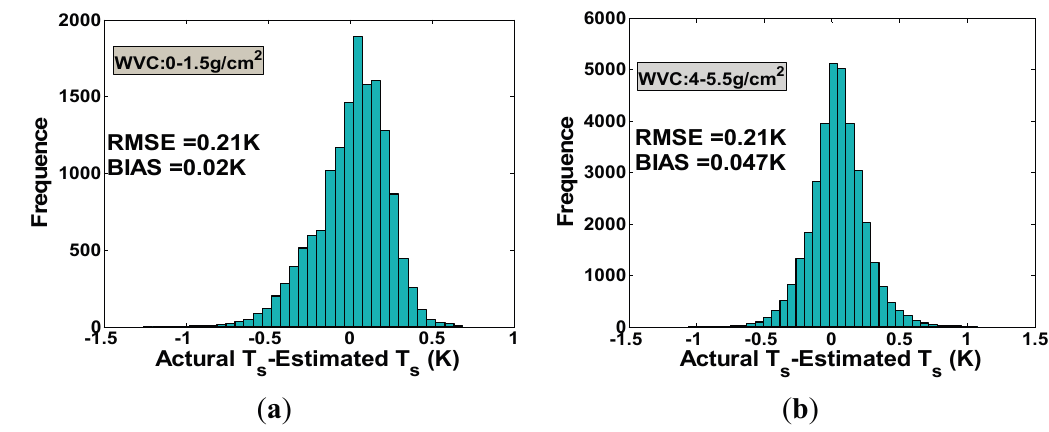
Figure 9. Total LST retrieval error caused by uncertainties of NE Δ T, emissivity, and WVC. ( a ) High LST conditions (LST = 305~325 K). ( b ) Low LST conditions (LST = 265~295